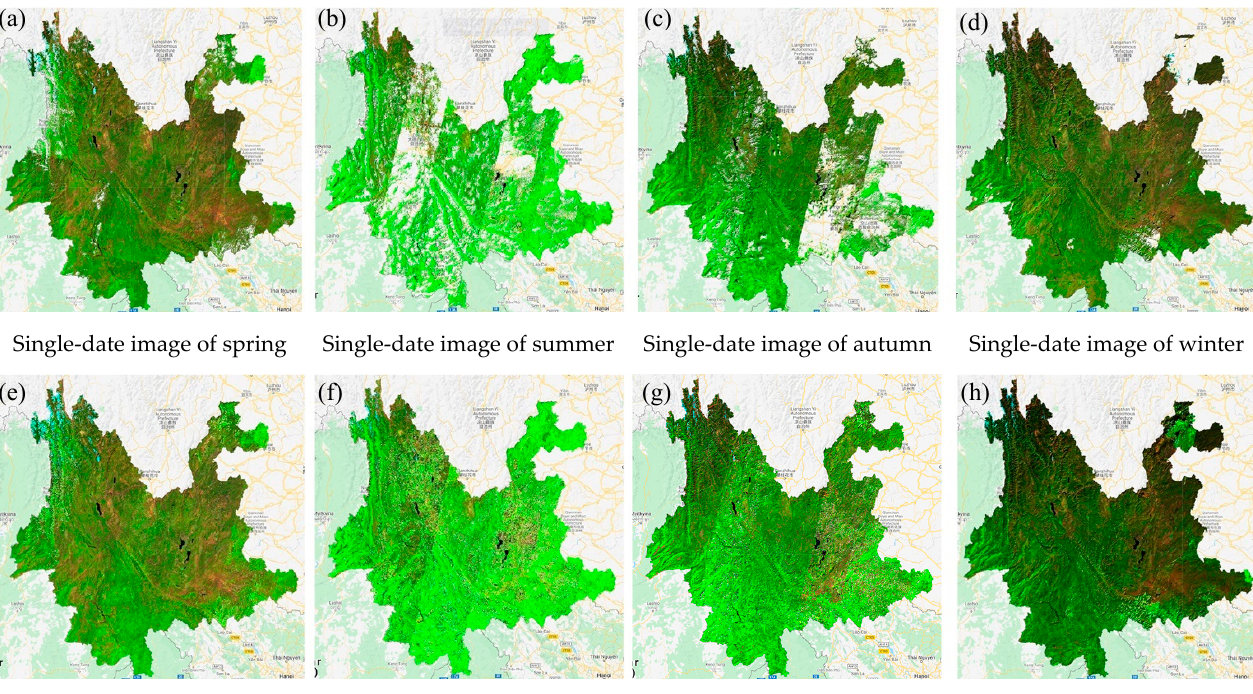
Figure 9. Single-date images and median-based seasonal composite images of four seasons. Four seasonal single-date images were obtained by selecting and mosaicking 35 images with the least amount of clouds in each season and the pixels with cloud were eliminated during mosaicking. False color composite of SWIR1/NIR/Red as RGB. ( a ) Single-date image of spring, ( b ) Single-date image of summer, ( c ) Single-date image of autumn, ( d ) Single-date image of winter, ( e ) Median composite of spring, ( f ) Median composite of summer, ( g ) Median composite of autumn, ( h ) Median composite of winter.